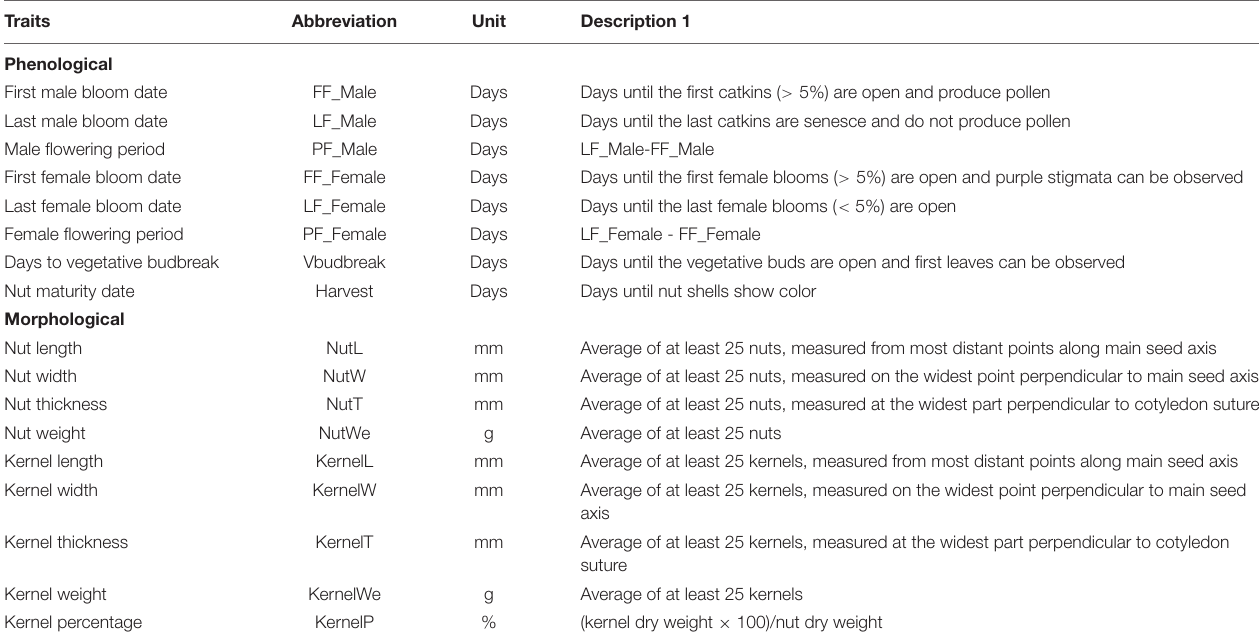
TABLE 1 | List and description of the 17 characters considered in the morpho-agronomic characterization of the 58 hazelnut accessions and cultivars. Traits Abbreviation